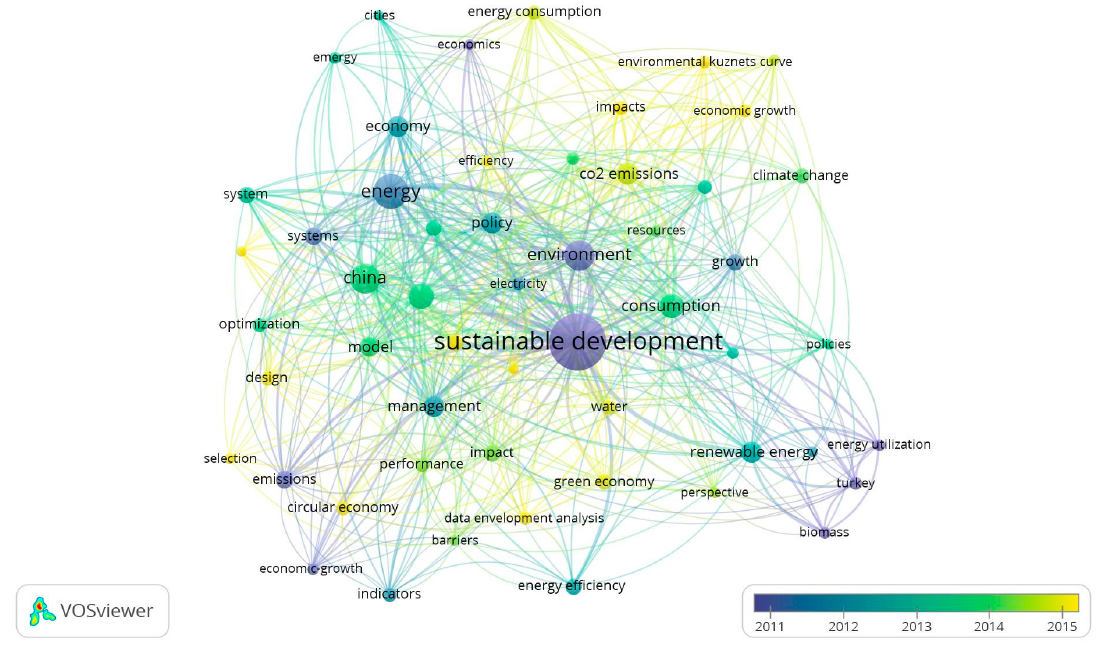
Figure 8. Keywords of sustaniable development from 2001 to 2018.